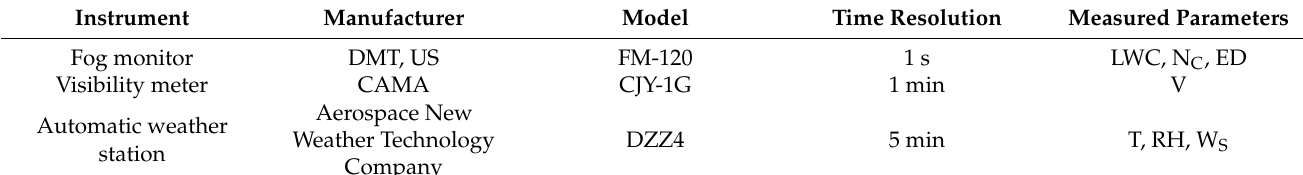
Table 1. Observation equipment and related technical parameters.